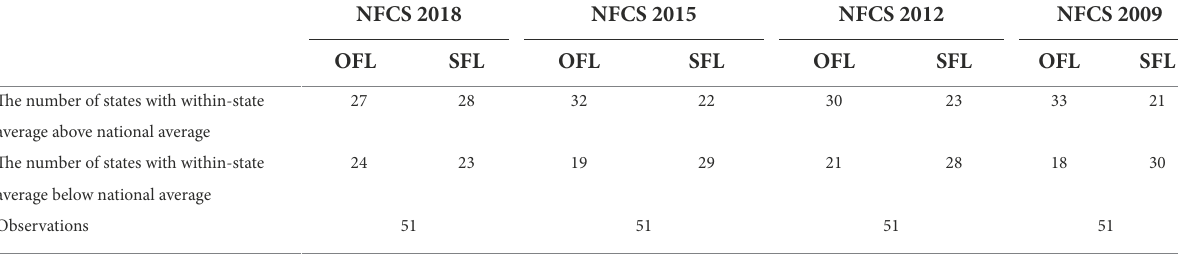
TABLE 5 State distribution above the state and national average FL